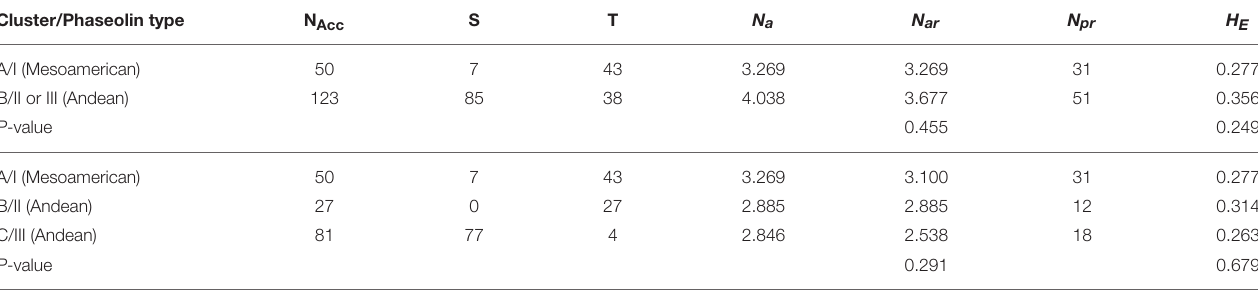
TABLE 1 | Genetic diversity of Croatian common bean accessions based on 26 microsatellite loci. Cluster/Phaseolin type